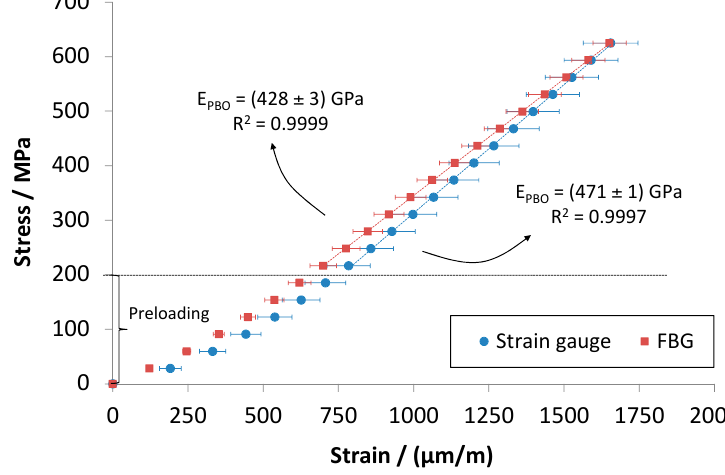
Figure 6. Tensile tests carried out on PBO textile instrumented with FBG and strain gauge: Averaged stress-strain curves.